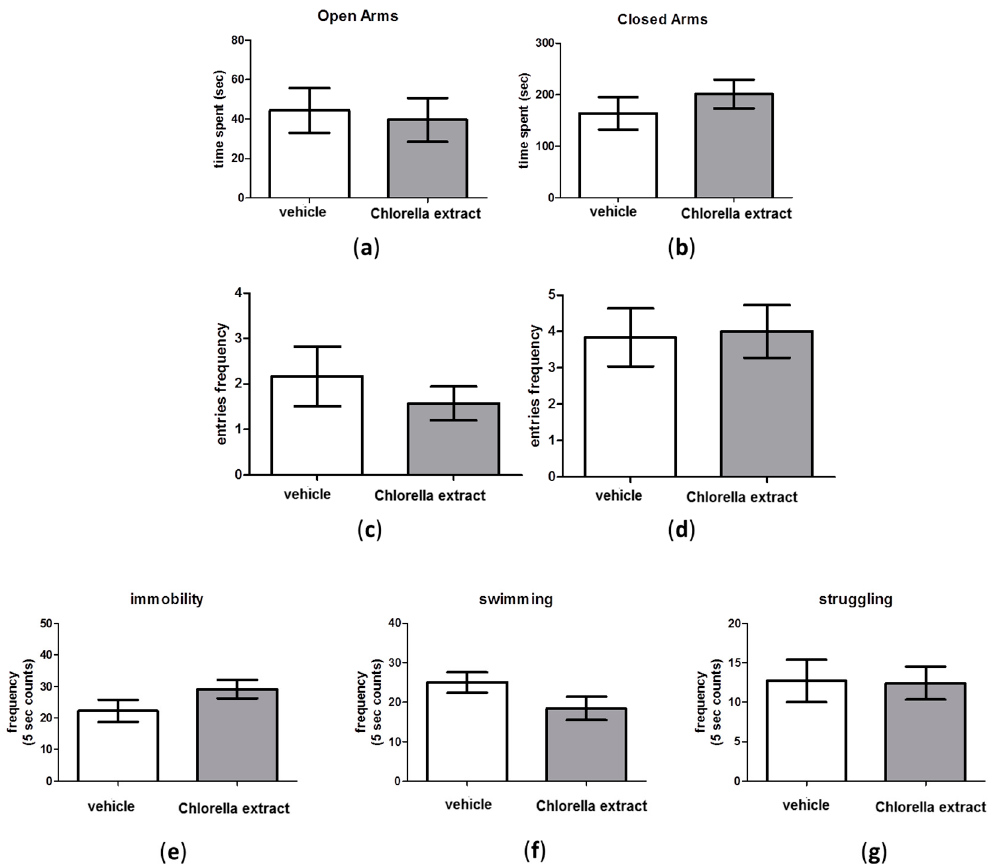
Figure 3. The forced swimming test and elevated plus maze test in male Wistar rats after Chlorella sorokiniana extract or vehicle administration. ( a ) Amount of time spent in open and ( b ) closed arms, ( c ) the entries frequency into open and ( d ) closed arms in the EPM test; ( e ) Immobility; ( f ) swimming and ( g ) struggling frequency in the FST. Male Wistar rats were treated with Chlorella sorokiniana extract (Chlorella extract, 30 mg/kg/mL dark bar) or vehicle (sunflower oil 1 mL/kg, empty bar) administration. Data are expressed as mean ± SEM ( n = 8 per